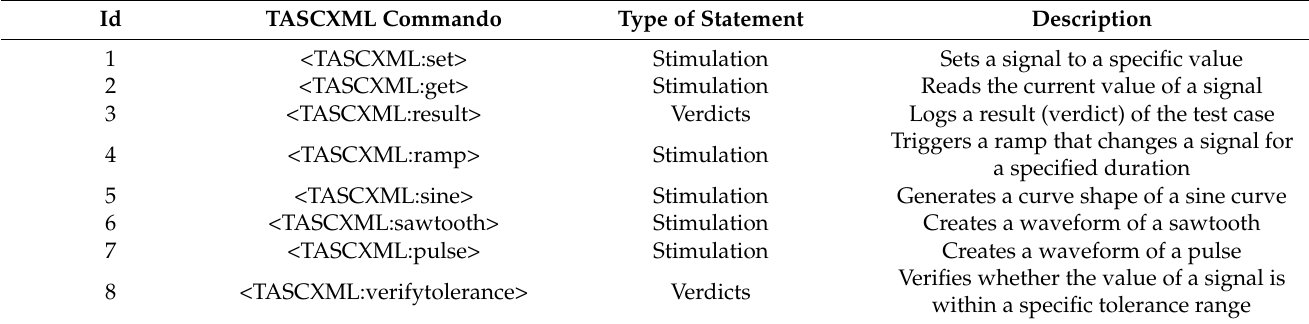
Table 2. TASCXML